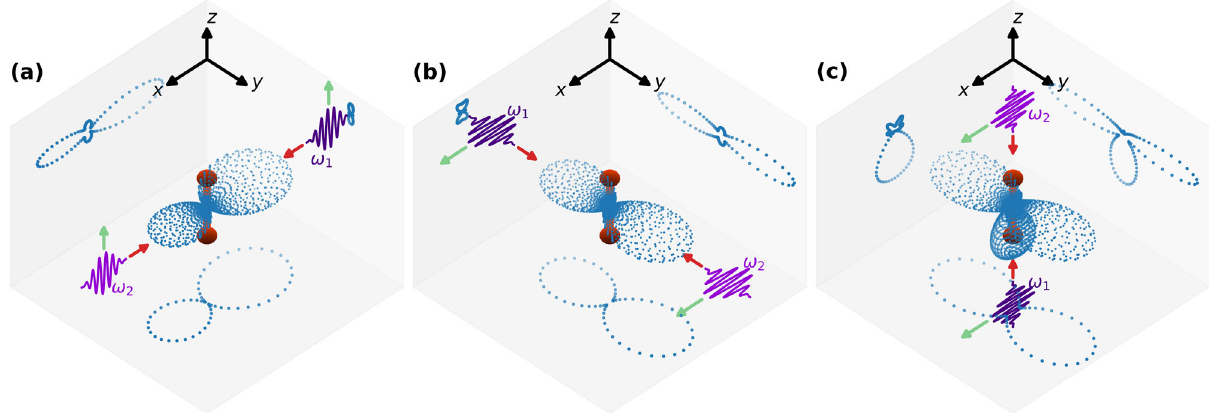
Fig. 3 Molecular-frame photoelectron angular distributions for the case of two counter-propagating pulses. The central energies are 20 a.u. (blue pulse) and 15 a.u. (purple pulse). Green arrows: pulse polarization direction. Red arrows: pulses incidence direction. Dark orange spheres: nuclei. Cuts on the xy , xz, and yx planes are also shown. Molecule is along the z axis. a Polarization along the z axis, incidence directions along the x axis. b Polarization along the x axis, incidence directions along the y axis. c Polarization along the x axis, incidence directions along the z axis.